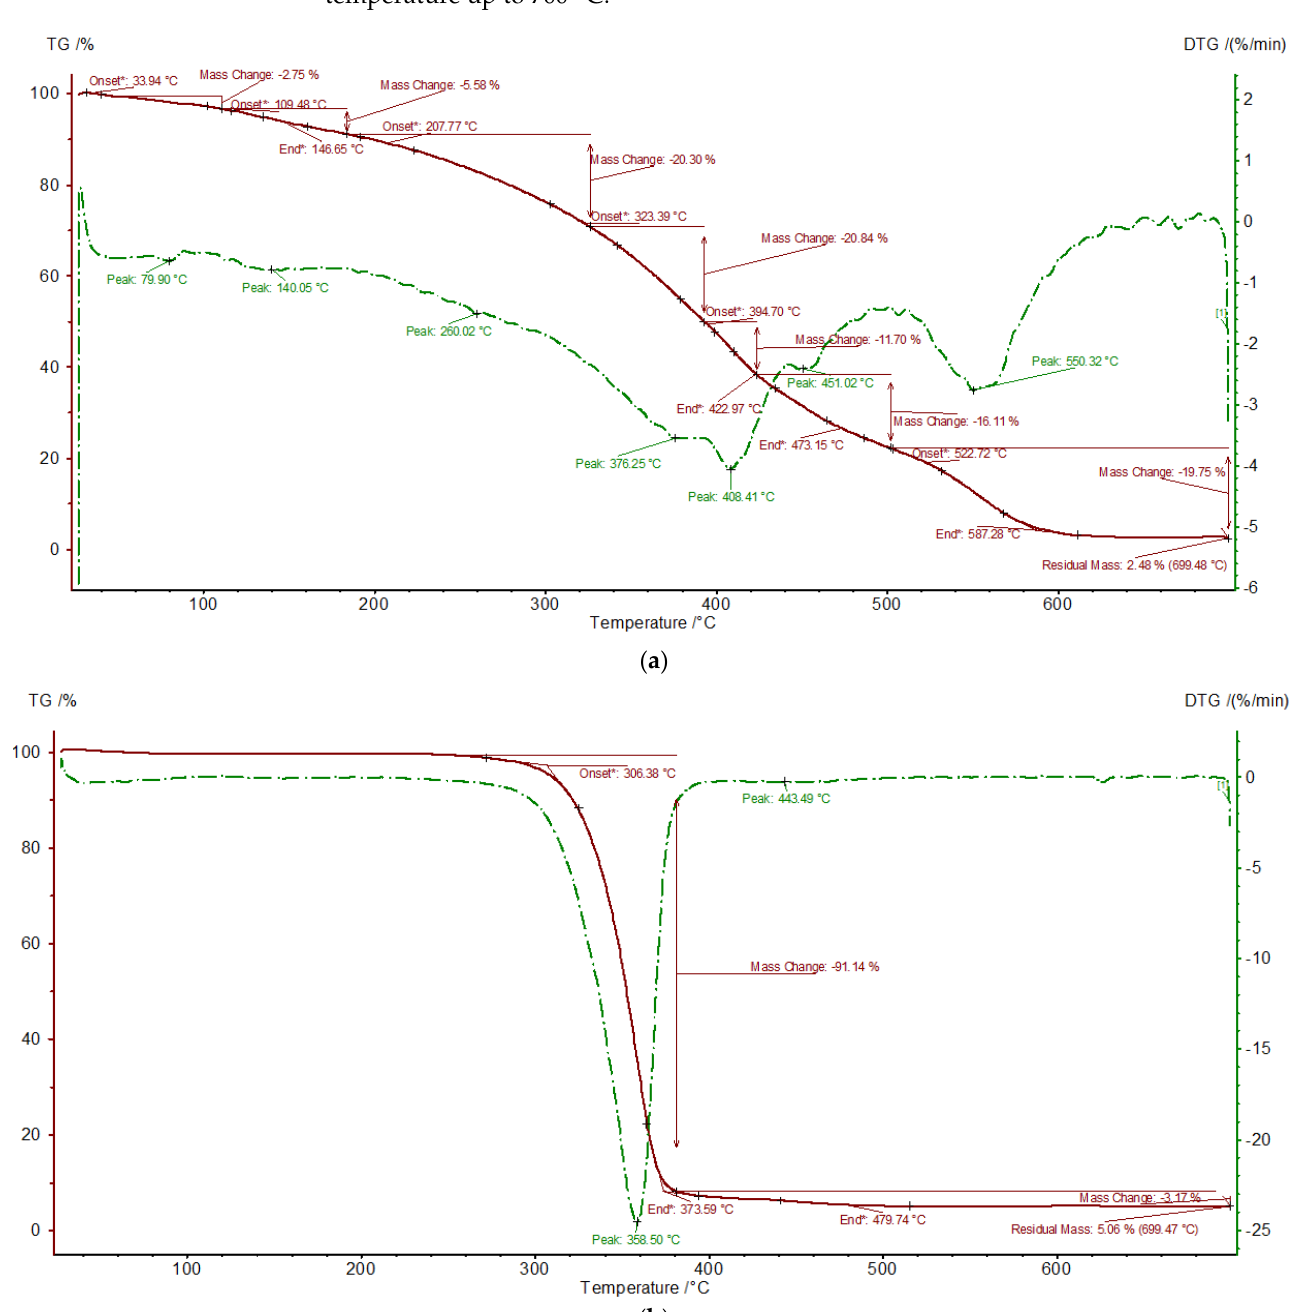
Figure 5 . Thermogravimetric (red) and differential thermogravimetric (green) curves of APDMS ( a ) and APDMS-CL ( b ) .